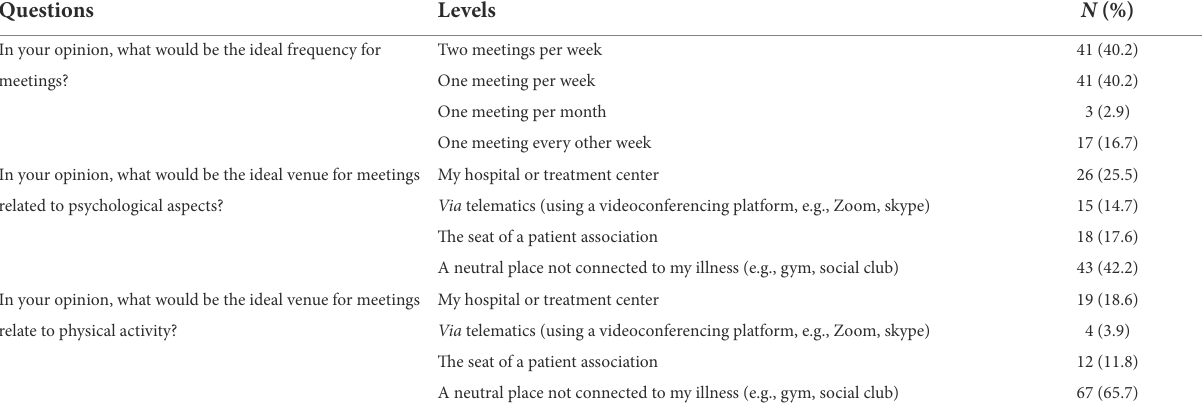
TABLE 3 Survey with young adults with MS: needs and preferences regarding intervention modalities and timing.